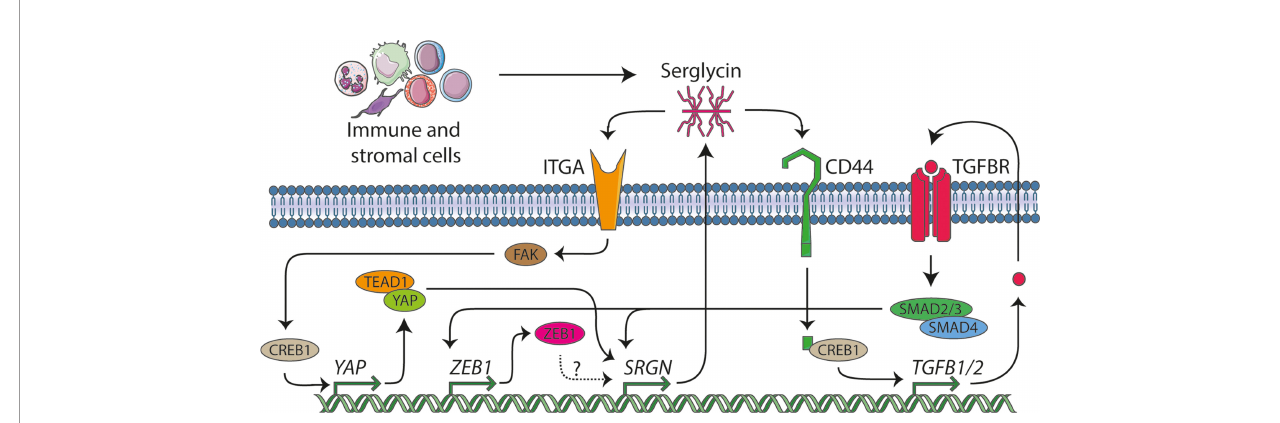
FIGURE 5 | The serglycin signaling network. In this manuscript we identify serglycin to be a TGF- b responsive gene that is induced during epithelial mesenchymal transition (EMT), and we propose that ZEB1 might be a potential transcription factor that can induce serglycin expression. From previous publication, serglycin has been shown to be able to act in an autocrine manner through the TGF- b pathway and via the YAP transcriptional co-activator. Several lines of evidence show that immune and stromal cells are major contributors of serglycin in the tumor microenvironment, and we hypothesize that expression of serglycin in the tumor microenvironment can stimulate breast cancer cells to undergo